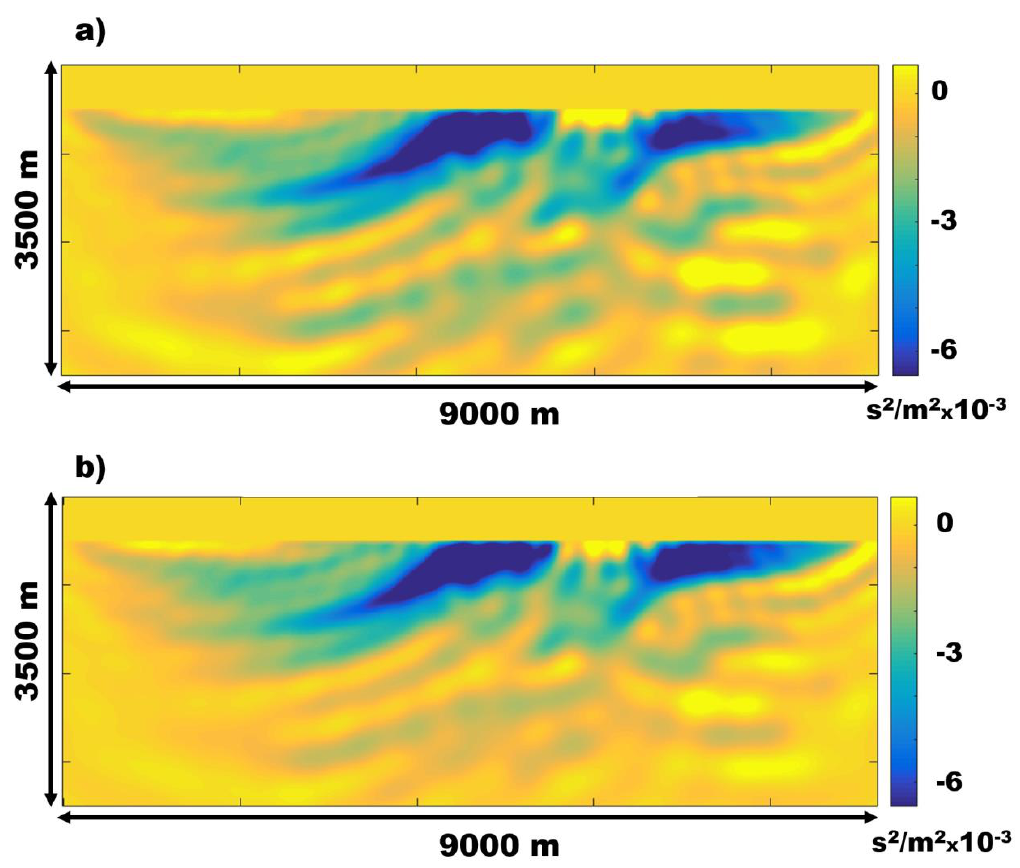
Figure 4. ( a ) Classic FWI gradient for 3 Hz calculated in the start model. ( b ) The asymptotic FWI gradient for 3 Hz calculated in the same start model.